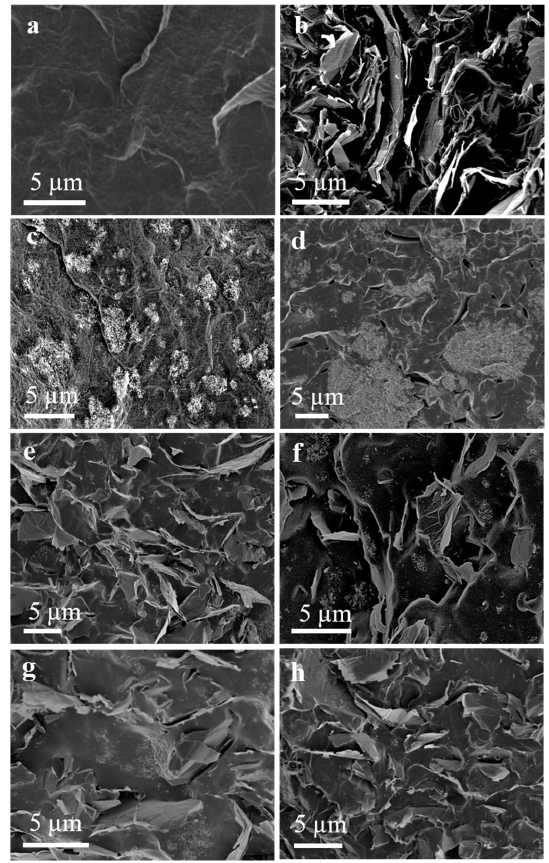
Figure 4. SEM cross-sections of TPU composites. DIW forming sample: ( a ) Pure TPU; ( b ) 10 wt% GNPs-TPU; ( c ) 10 wt% MWCNTs-TPU; ( d ) mold forming of 10wt% (MWCNTs: GNPS = 1:2)-TPU; DIW forming sample: ( e ) 10 wt% (MWCNTs: GNPs = 3:1)-TPU; ( f ) 10 wt% (MWCNTs: GNPs = 2:1)-TPU; ( g ) 10 wt% (MWCNTs: GNPs = 1:1)-TPU; ( h ) 10 wt% (CNTs: GNPs = 1:2)-TPU.